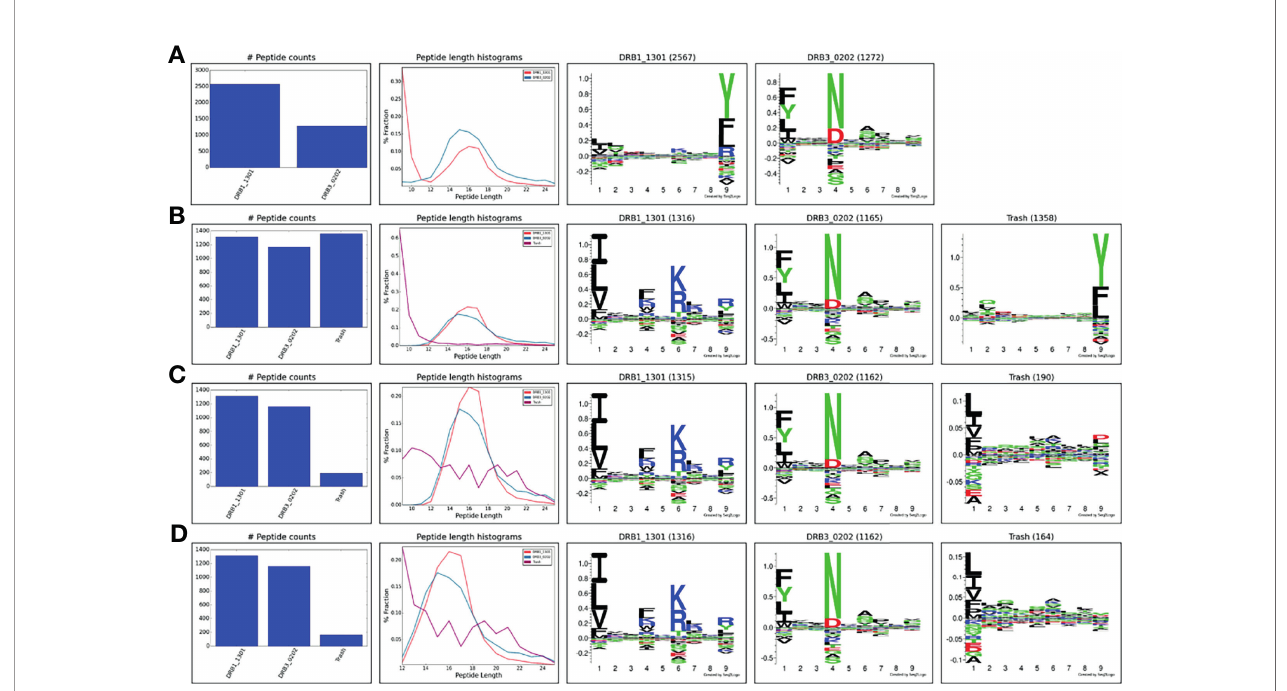
FIGURE 5 | HLA-DR motif deconvolution for the IHW09060 dataset using different strategies to deal with co-immunoprecipitated MS contaminants. (A) Peptide length 9-25, excluding the use of the trash bin option (achieved by setting the trash bin threshold to 101%), (B) Peptide length 9-25, trash bin 20%, (C) Peptide length 9-25, exclude class I binders, trash bin 20%, (D) Peptide length 12-25, trash bin